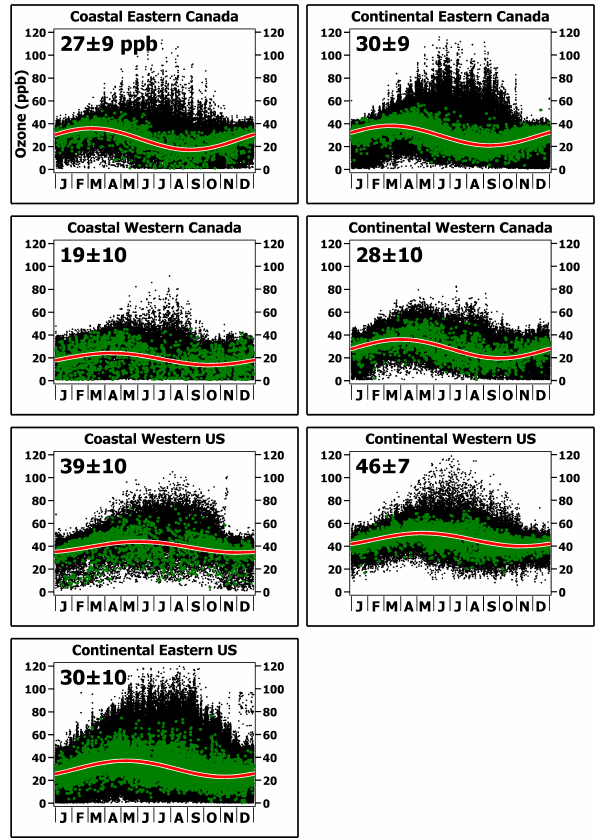
Fig. 6. The seasonal variations of the baseline ozone mixing ratios (ppb) relative to all data for Coastal/Continental Eastern Canada, Coastal/Continental Western Canada, Coastal/Continental Western US, and Continental Eastern US regions. The black dots show all of the six-hour averaged mixing ratios for all data from 1997–2006. The green dots show the six-hour averaged mixing ratios associated with the baseline air flows. The red fitted curves are the calculated seasonal cycles. The multi-site annual mean (ppb) and ± 1 standard deviation are shown in the top left corner for each